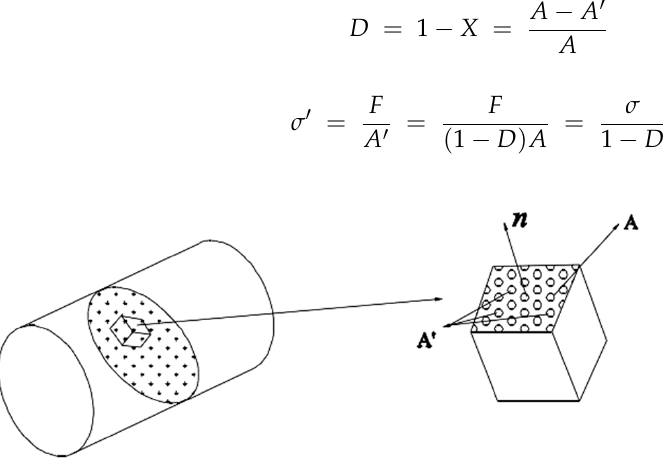
Figure 3. Continuity diagram.